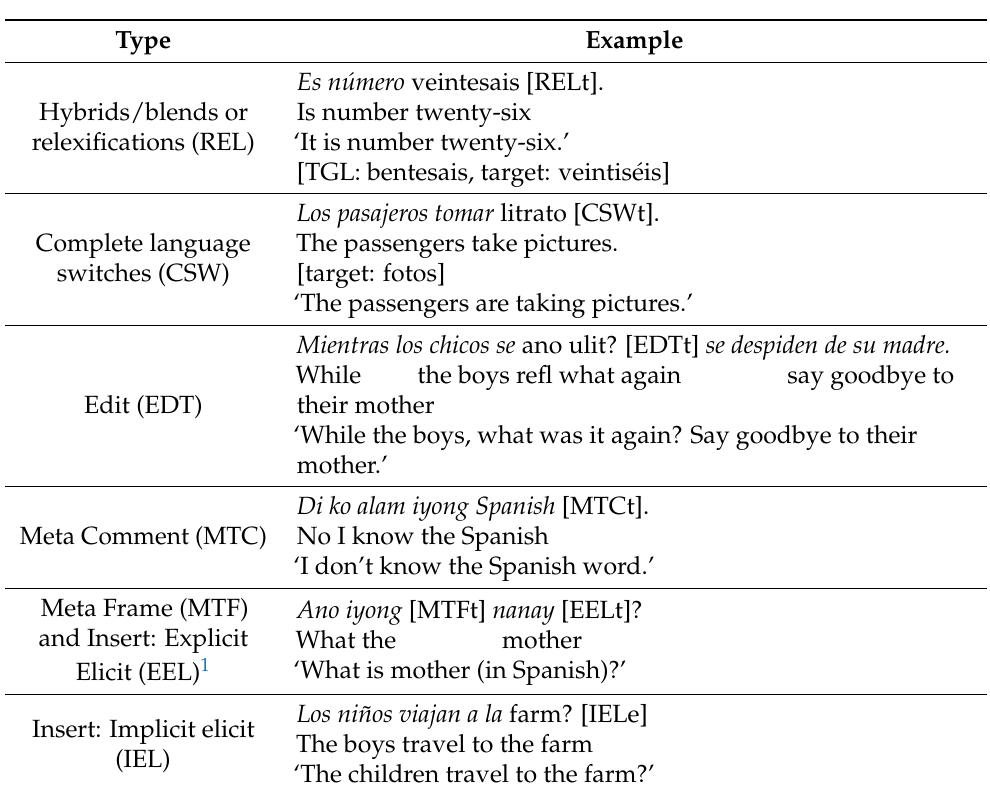
Table 4. Form-based